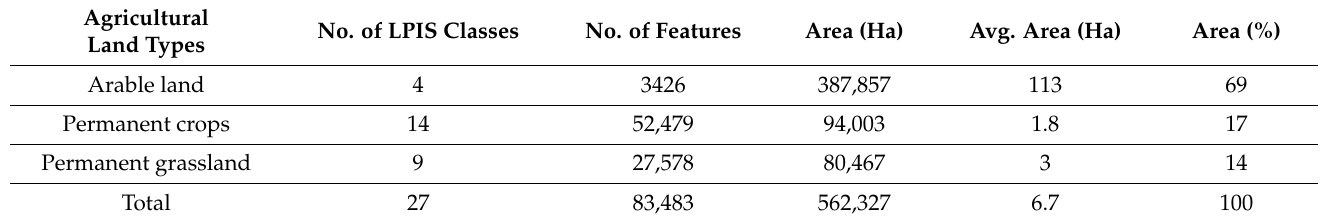
Table 1. Agricultural land types in Foggia